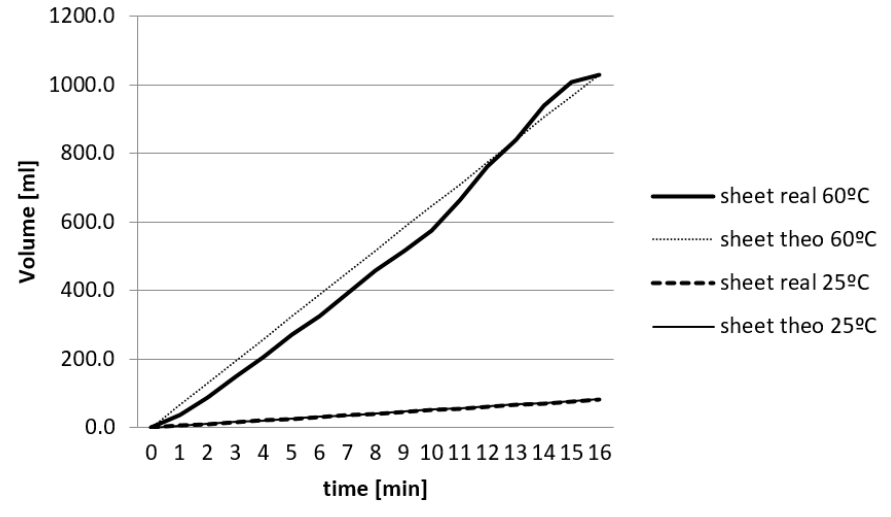
Figure 6. Comparison of the hydrogen volume generated from an aluminum sheet of 20 × 30 × 0.5 mm 3 (sheet) in a 7.5 M NaOH solution (without alcohol), at a bath temperature of 60 °C and 25 °C. Table 7. Comparison of the effect of temperature on hydrogen generation.